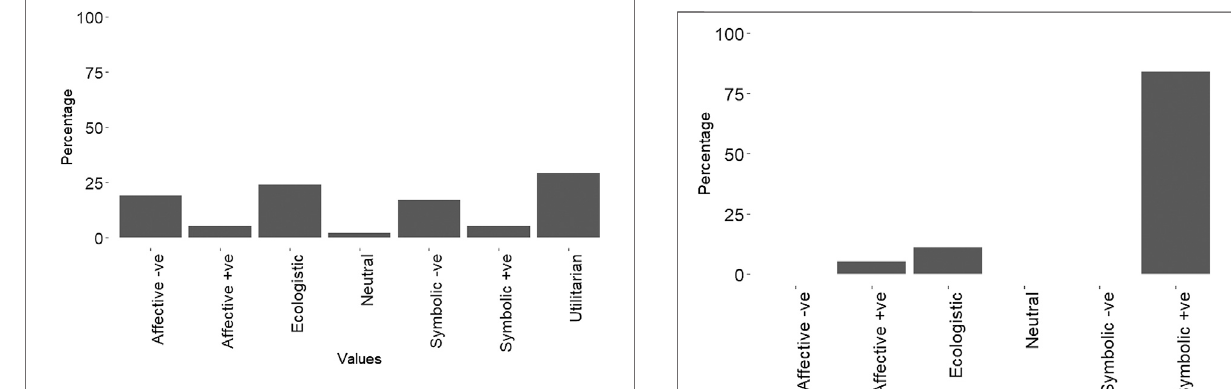
FIGURE 5 | The predominant values ascribed to the snow leopard were utilitarian (28.5%), referring to its importance in domestic use or trade, sport, medicine and ritual, and ecologistic (23.8%), referring to observations about its behavior and ecology, followed by negative affective (19%), negative symbolic (16.6%), positive affective (4.7%), positive symbolic (4.7%) and neutral values (2.3%). The total number of narratives was 43.